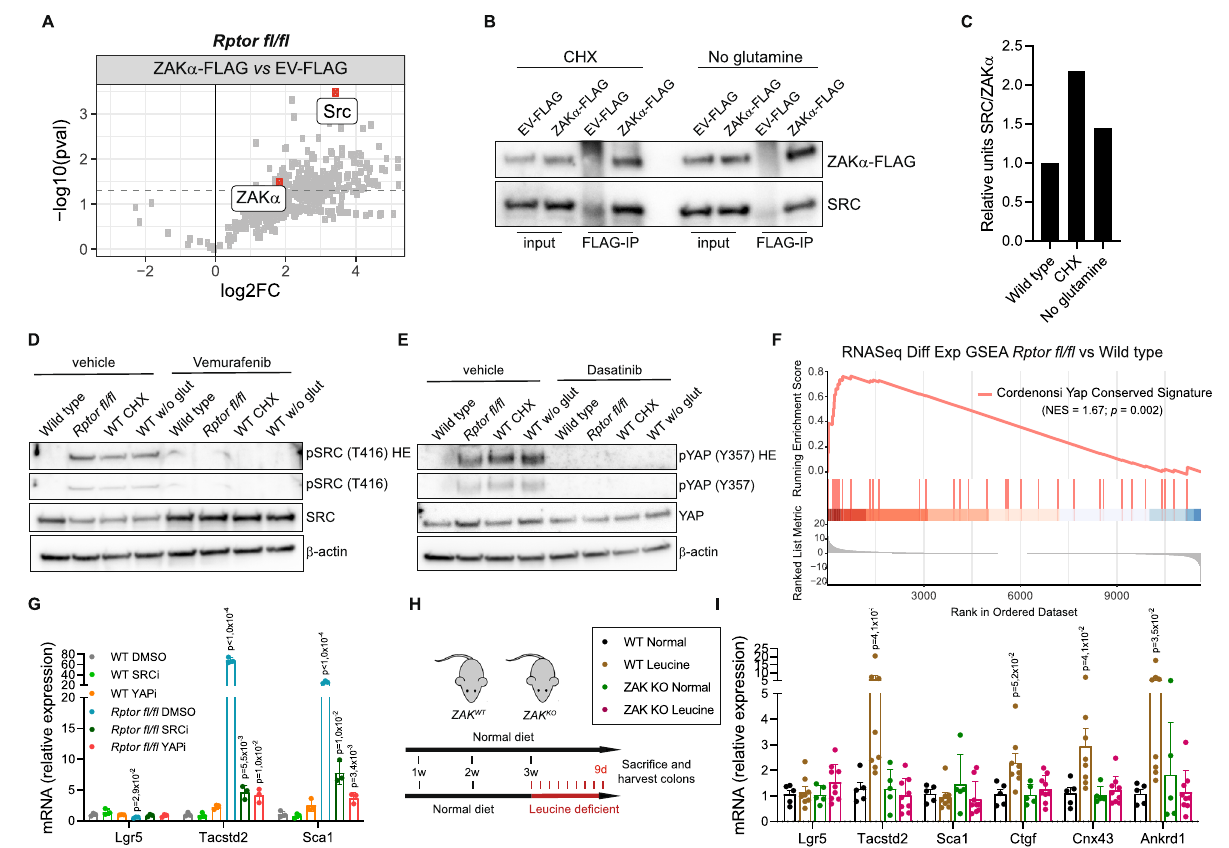
Fig. 4 | ZAK α activates the SRC-YAP axis during ribosome impairment and resultsinISCsidentityswitchinvivoduringleucinedeprivation.A Volcanoplot depicting differentially enriched interactors of ZAK α in Rptor fl / fl organoids, using RIME-MS( n =2biologicalreplicates).AnemptyvectortaggedFLAGbaitisusedasa control.Signi fi cancewhen p -value ≼ 0,05( t -test,two-tailed). B Immunoprecipitation of ZAK α -FLAG con fi rms interaction with SRC in organoids treated with cyclohex- imide(0.015ug/ml)anddeprivedfromglutamine.EV_FLAGisusedasacontrol.One biological animal was used. C Quanti fi cation of the western blot shows enrichment of ZAK α -SRC binding in organoids treated with cycloheximide (0.015ug/ml) and deprived from glutamine, compared with wild type cells. D Western blot showing activation of SRC in Rptor fl / fl , low dose cycloheximide and glutamine-deprived organoids compared to wild type. This activation is dependent on ZAK α activity, as inhibitionwithvemurafenibabolishesSRCphosphorylation(T416). β -actinservesas aloadingcontrol.Bluepanelhasahigherexposure.Blotsweredoneononeanimal. E Western blot showing activation of YAP in Rptor fl / fl , low dose cycloheximide and